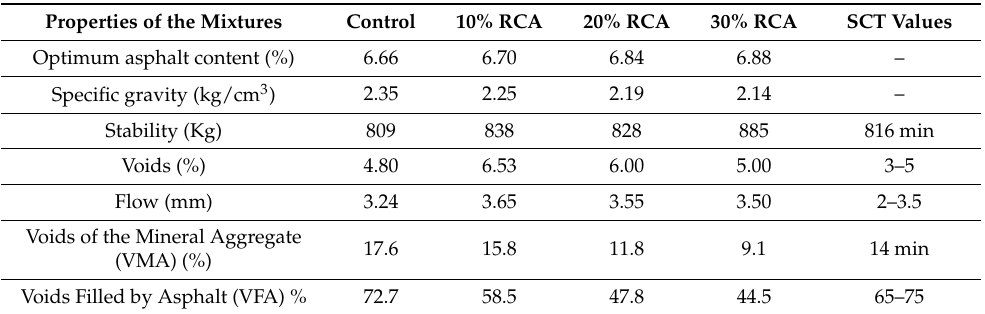
Table 2. Results of the design of asphaltic mixtures.